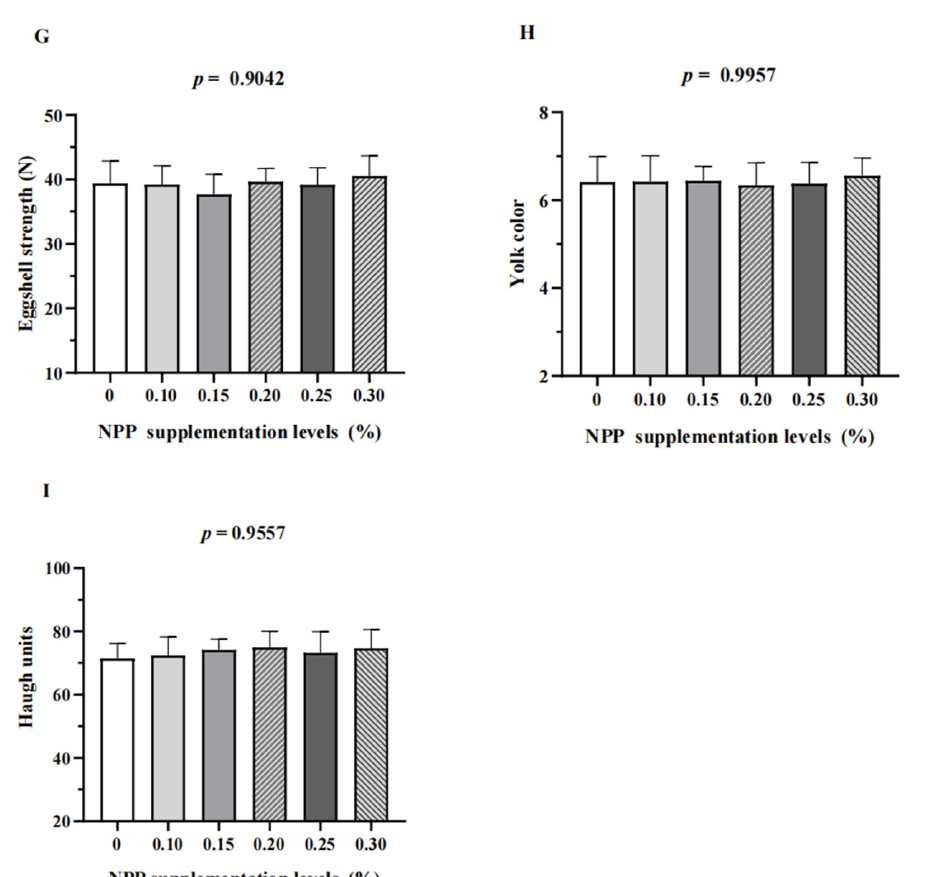
Figure 1. Effect of the level of dietary NPP supplementation on the production performance and egg quality of Hy-Line Brown laying hens (69–78 weeks of age) fed a phytase-containing diet. Production performance ( A – E ); egg quality ( F – I ). All data were subjected to linear analyses, but significance was not observed ( p > 0.05). The statistical unit was each replicate ( n = 5) for the production performance and was each egg ( n = 50; 10 eggs per replicate were selected randomly) for egg-quality parameters. Table 4. Effect of levels of dietary NPP supplementation on the serum parameters and